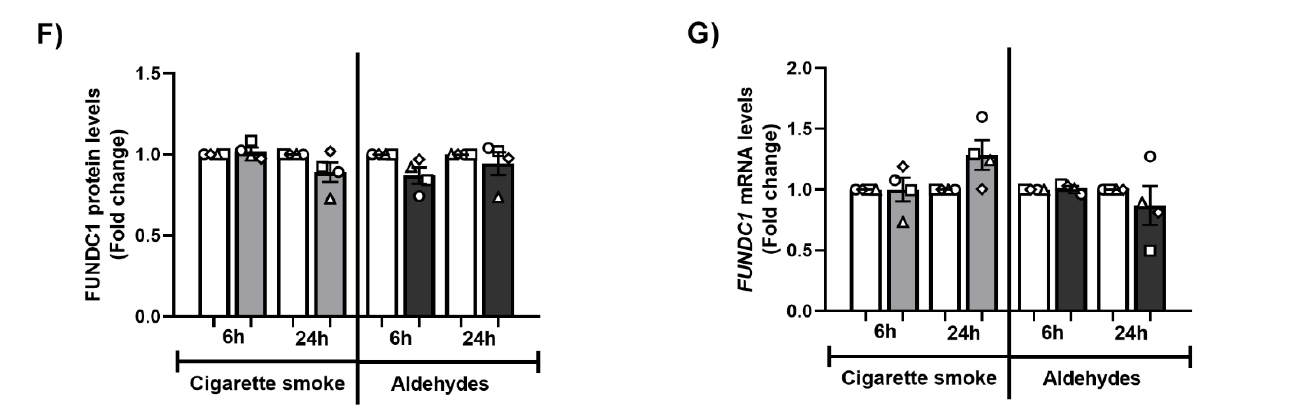
Figure 4. Decreased protein levels of markers associated with receptor-mediated mitophagy after CS exposure. Differentiated human primary bronchial epithelial cells (PBEC) from non-COPD subjects ( n = 3–4 donors) were exposed to smoke of one Marlboro Red cigarette (CS), or a mixture of acetaldehyde, acrolein, and formaldehyde (at concentrations equivalent to one cigarette), or air (control), under a continuous flow system using a puff-like exposure protocol. After recovery for 6 h or 24 h, whole cell lysates were harvested for analysis of ( A , B , D , F ) protein and ( C , E , G ) transcript abundance of key regulators involved in receptor-mediated mitophagy: BNIP3L, BNIP3, and FUNDC1. Representative Western blot images are shown for one replicate of one donor per experiment, reflective of the changes in all donors as quantified in the corresponding graph. Data are presented as mean fold change compared to air control ± s.e.m. The mean values of biological triplicates for each independent donor are represented by open circles, triangles, squares, or diamonds. Statistical differences between CS vs. air and the mixture of aldehydes vs. air were tested using a two-tailed paired parametric t -test. Statistical significance is indicated as * p < 0.05 and ** p < 0.01 vs. air